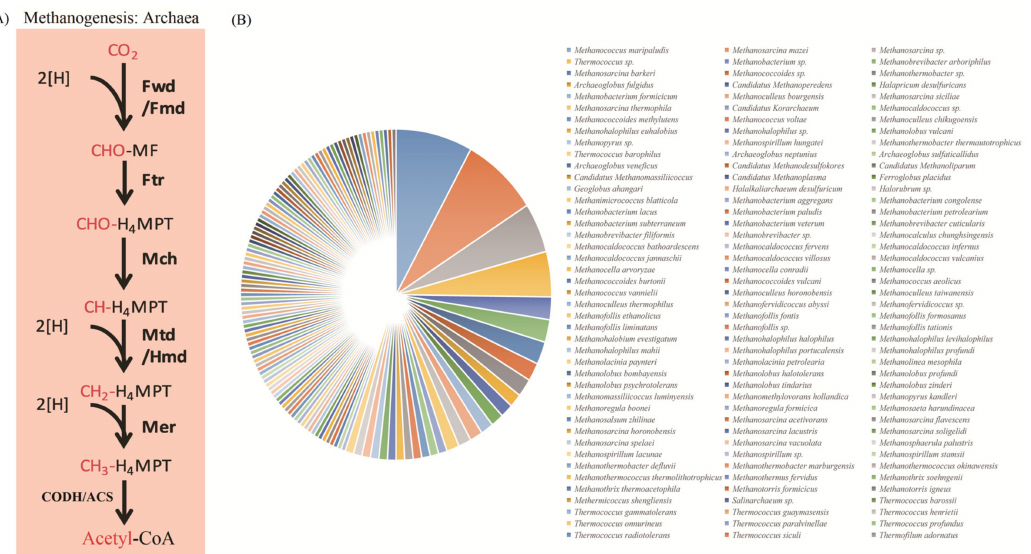
Figure 4. ( A ) The reactions of WL pathway in the archaea. The final step of this reaction is achieved through the CODH/ACS enzymatic complex. ( B ) Predicted strains of the archaea containing the WL pathway.